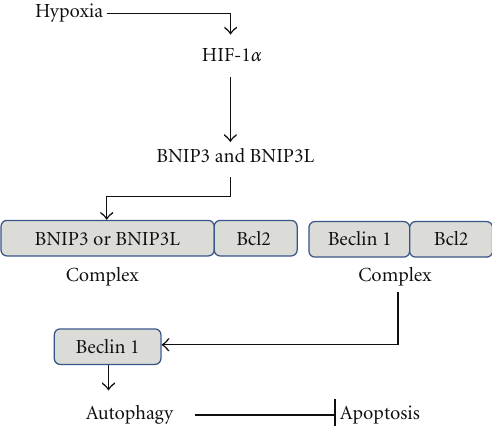
Figure 1: Hypoxia induces autophagy. Hypoxia activates HIF-1 α which in turn induces expression of the BH3-containing proteins BNIP3 and BNIP3L to compete with Beclin 1 for its interaction with Bcl2. As a consequence Beclin 1 is released to induce